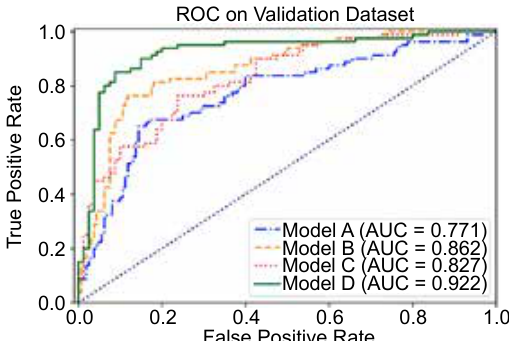
Figure 3B The receiver operating characteristic curves (ROC) and the area under ROC (AUC) of Model A (A), Model B (B), Model C (C) and Model D (D) from the testing data